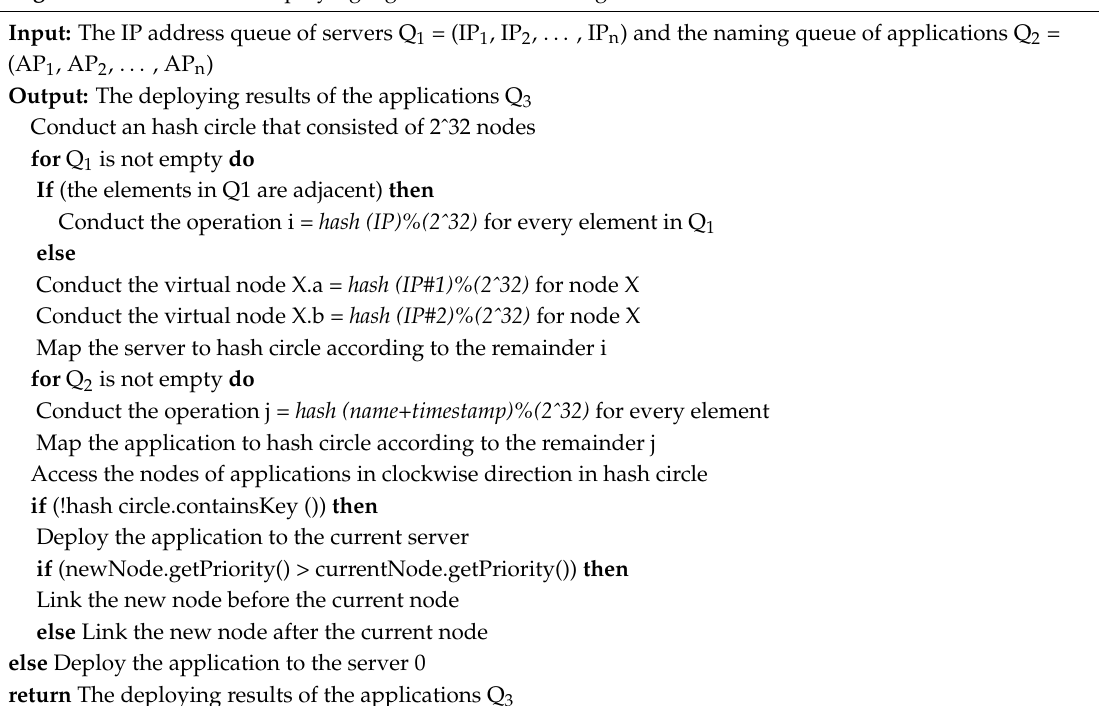
Figure 13. The deploying results of applications. Algorithm 1 DCH-based deploying algorithm in the heterogeneous sensor